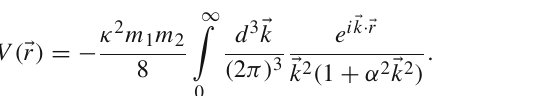
Fig. 3 Contour used to integrate the Fourier transformed potential in Eq. 29. We note that the complex function has poles at 0 and ± i α the substitution we